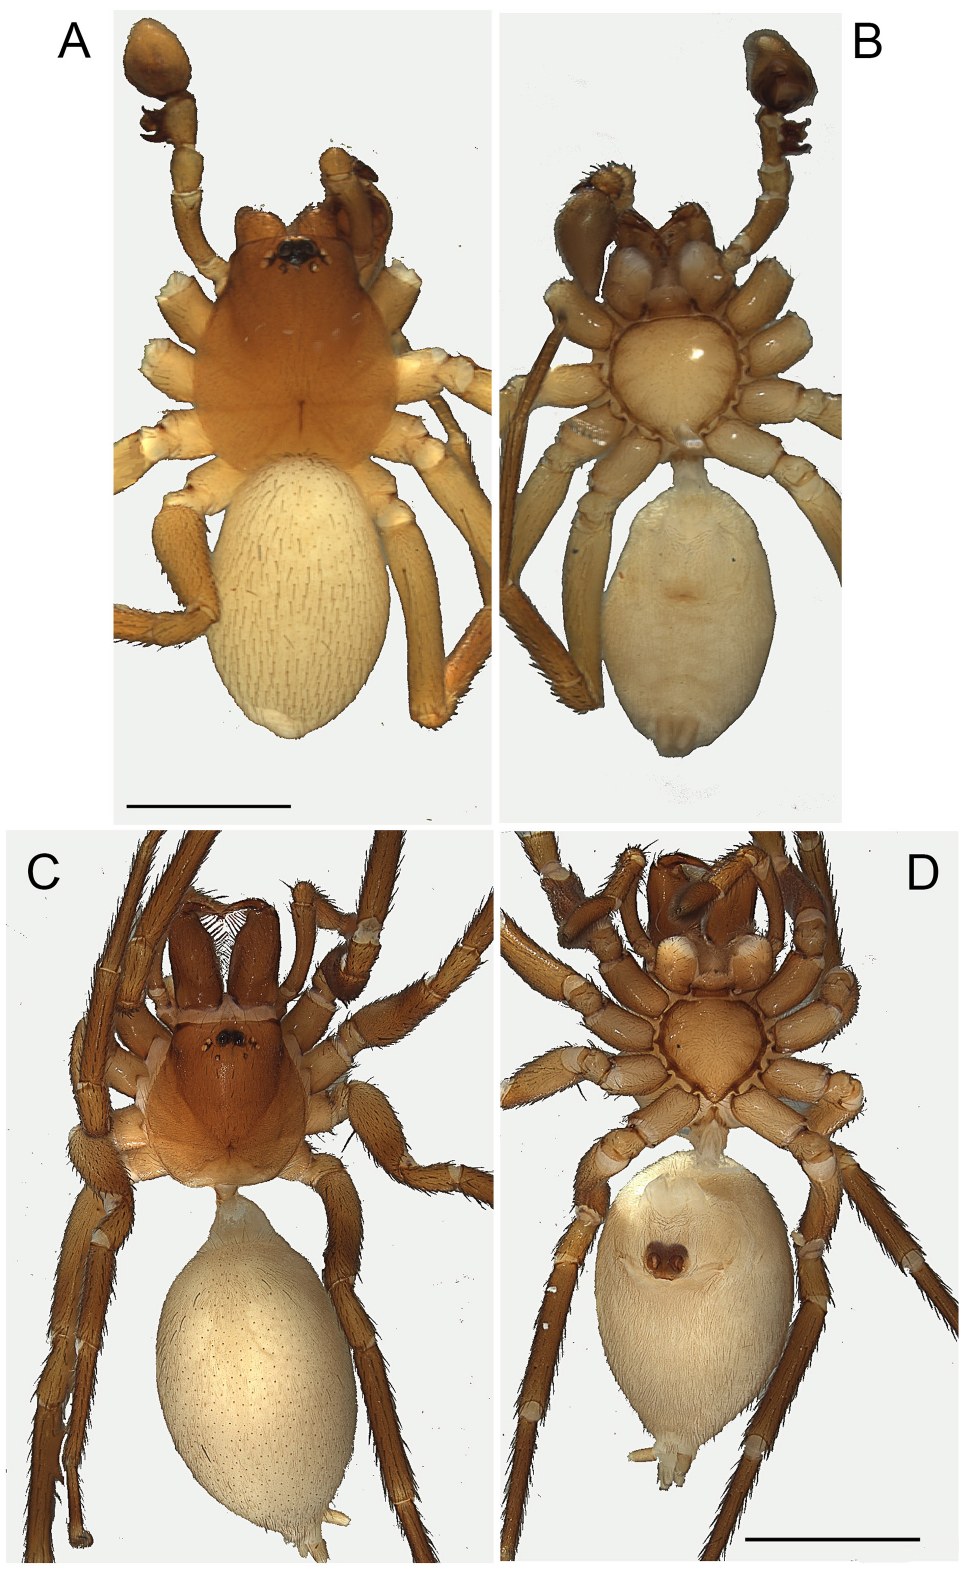
Fig. 34. Andromma raffrayi Simon, 1899 (both BE_RMCA_ARA_Ara 220165). A–B . ♂. C–D . ♀. A, C . Habitus, dorsal view. B, D . Habitus, ventral view. Scale bars: 1